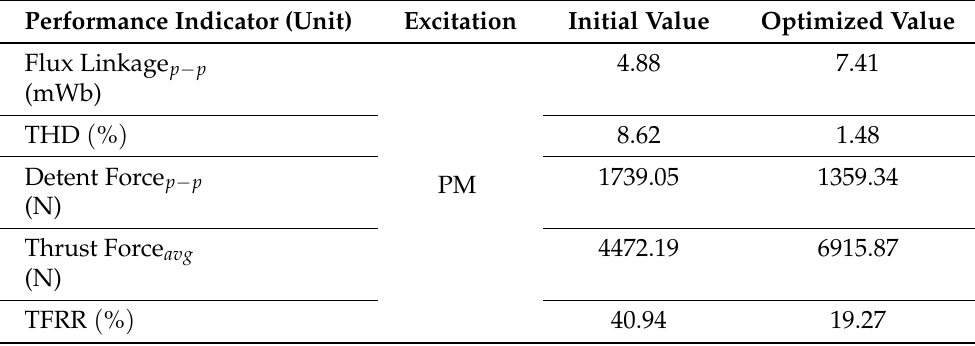
Table 3. Optimization results and